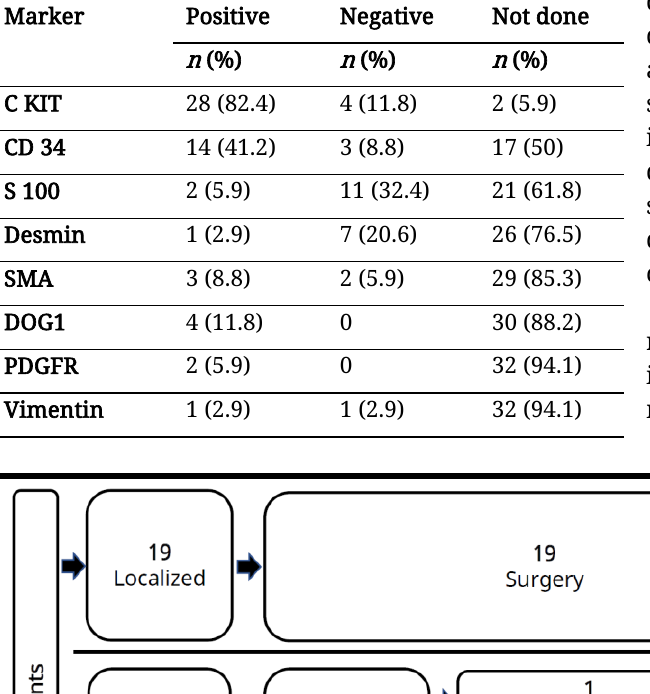
Table 2: Immuno-histochemical markers done in 34 patients with GIST Figure 1. Two patients with locally-advanced